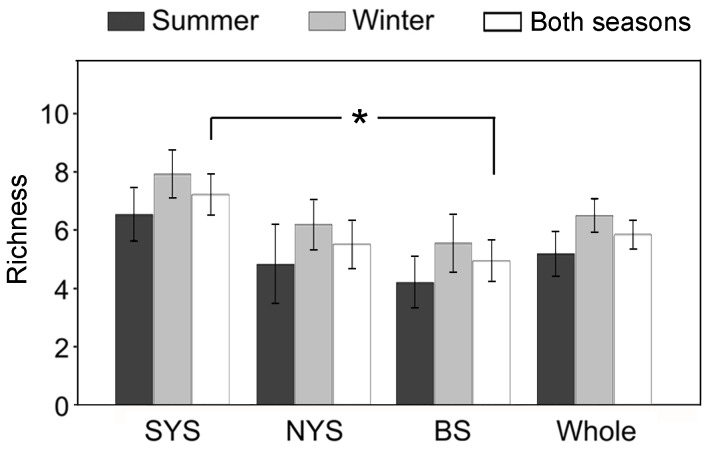
Spatial and seasonal variations of terminal restricted fragment numbers.Data were derived from water samples from South Yellow Sea (SYS), North Yellow Sea (NYS), and Bohai Sea (BS) and the combined area (Whole). The asterisk indicates significant difference (P<0.05).